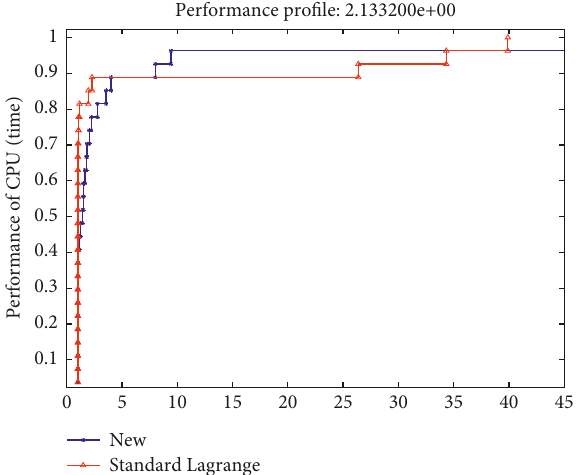
Figure 3: The performance of the given methods relative to CPU